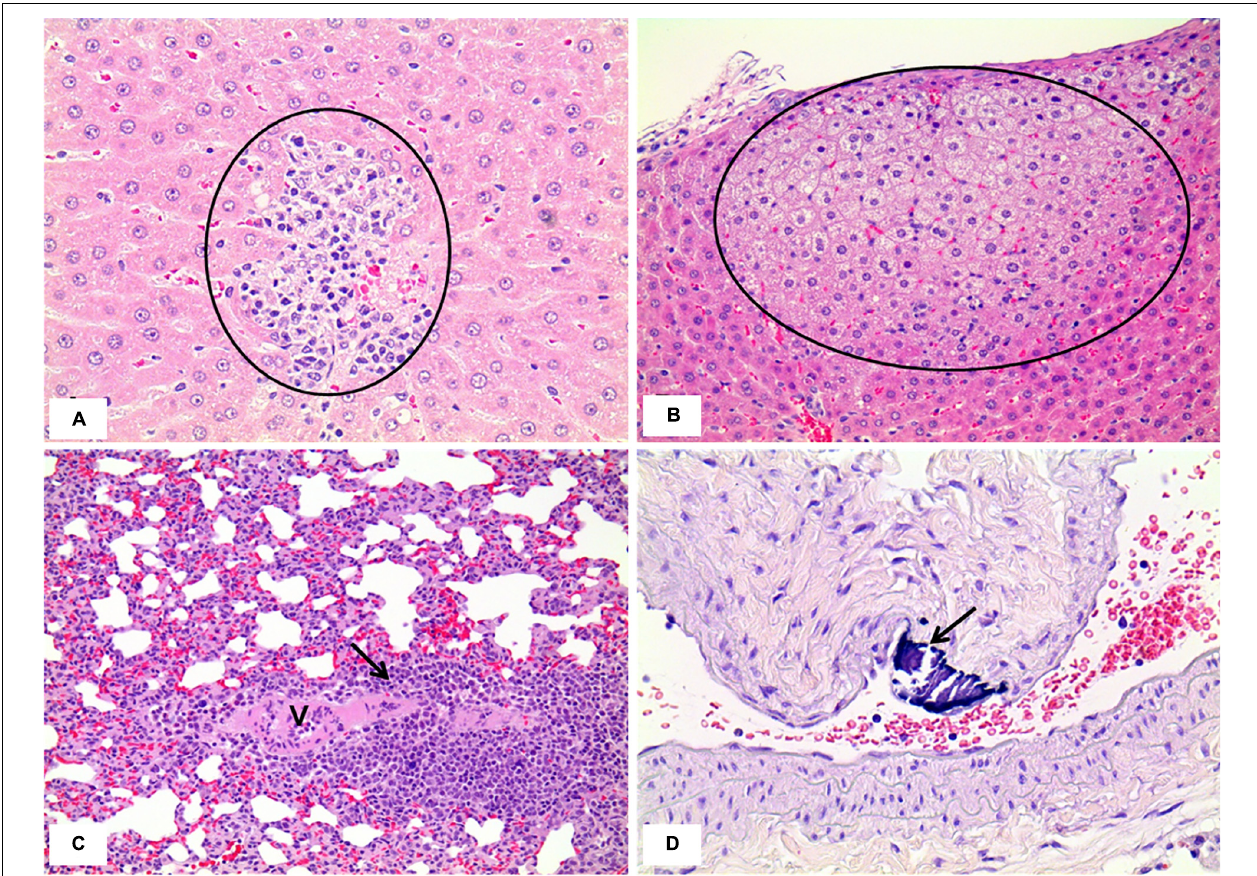
FIGURE 12 | Histopathology of livers and lungs in the male rats exposed by inhalation of the mixture of SM and PG for 2 weeks in the recovery study. The results represent focal mononuclear cell infiltration (circle in A , the control group) and tension lipidosis (circle in B , the medium group) in the liver and perivascular mononuclear cell infiltration (arrow in C , the vehicle control group) and vascular mineralization (arrow in D , the low group) in the lungs. H&E staining. Magnification = × 400 for A , × 200 for B , C , and D .